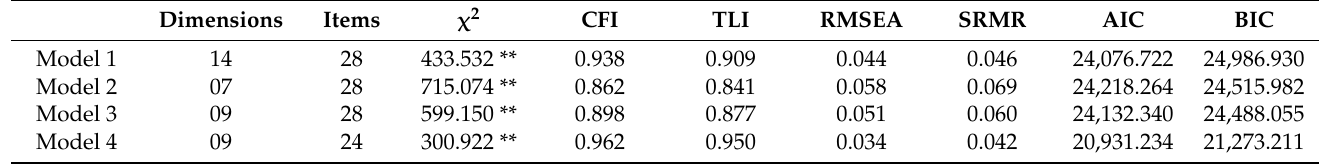
Table 3. Model fit indices of the CFA for the resulting clustering scale and the revised